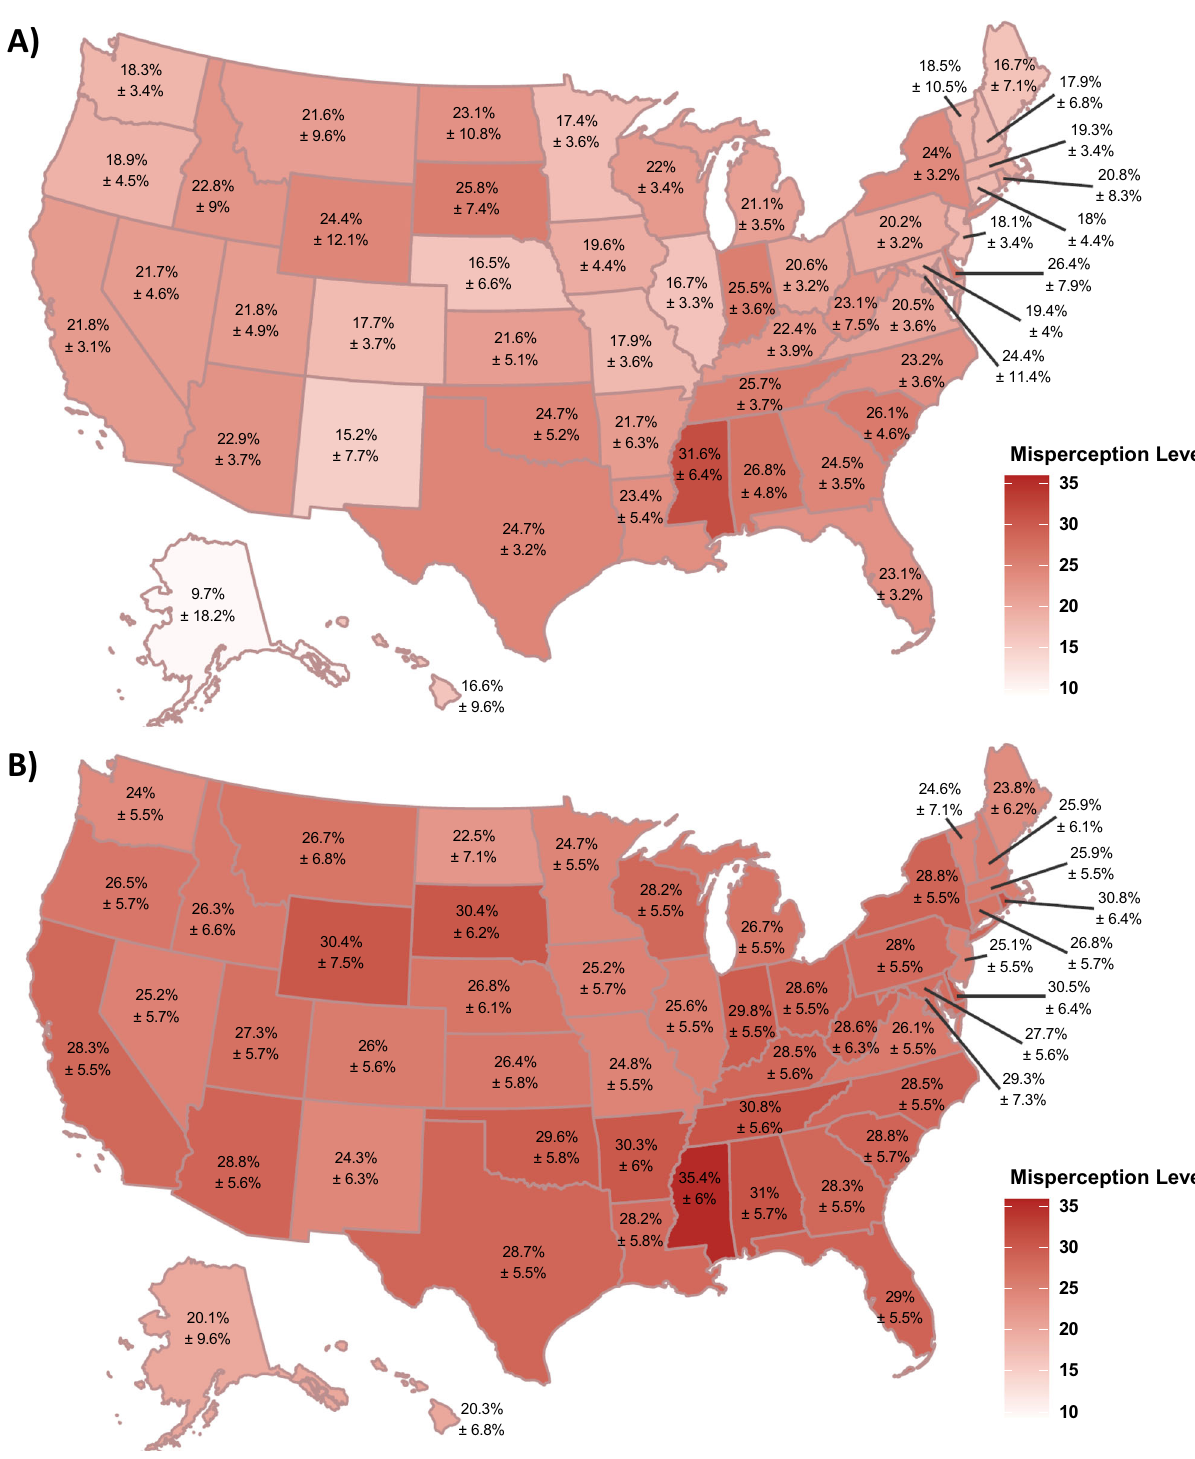
Fig. 4 | Pluralistic ignorance for climate worry and support for climate policy across the U.S. A shows pluralistic ignorance levels for worry about climate change by taking the difference from real and perceived national levels of climate change andaveragingthoselevels acrossparticipantsineachstate. B shows levels of pluralistic ignorance for climate policy, calculated by averaging the difference between real and perceived support levels across the four national policies